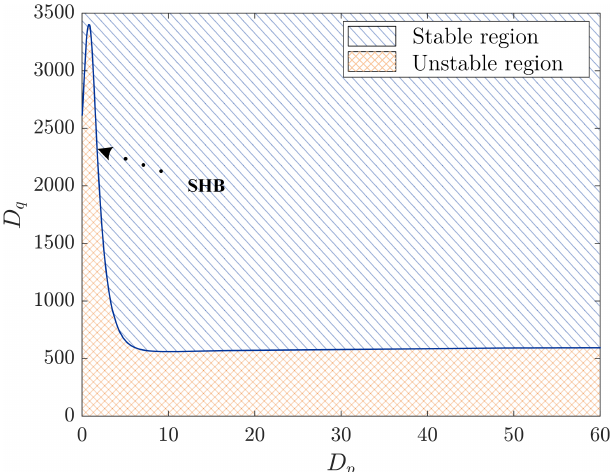
Figure 9. Stability region, when the gains vary D q – D p , with τ f = 0.002 s y τ v = 0.02